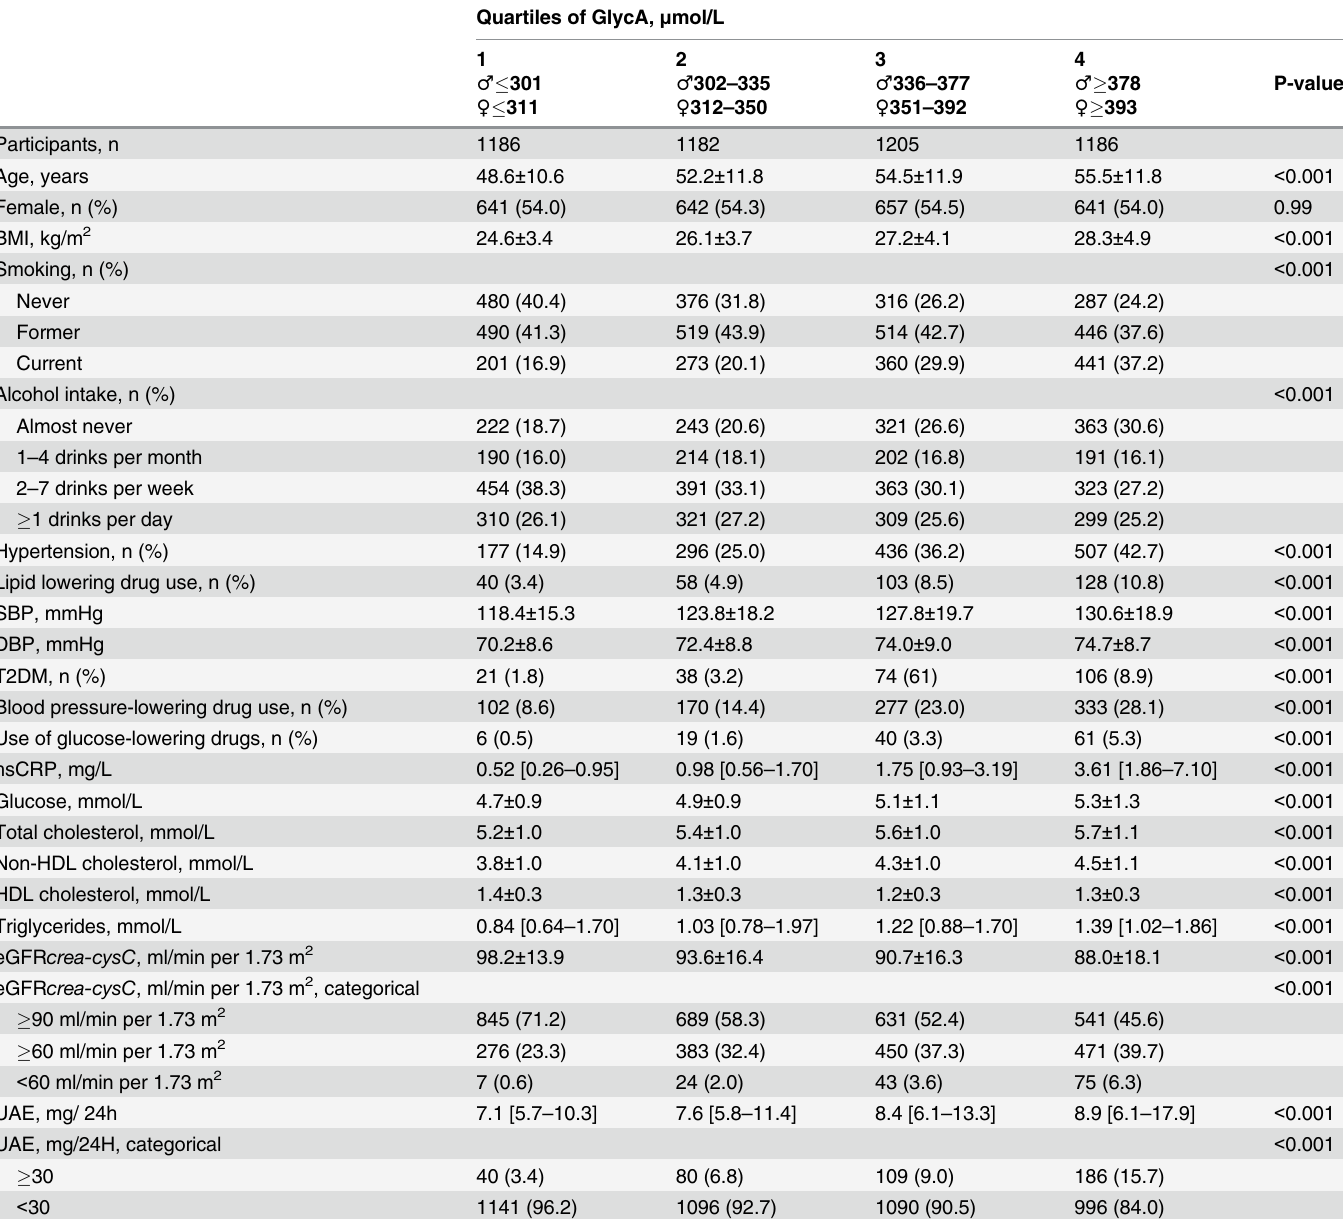
Table 1. Baseline characteristics according to sex-stratified quartiles of GlycA concentrations in 4,759 participants of the PREVEND study. Quartiles of GlycA, μ